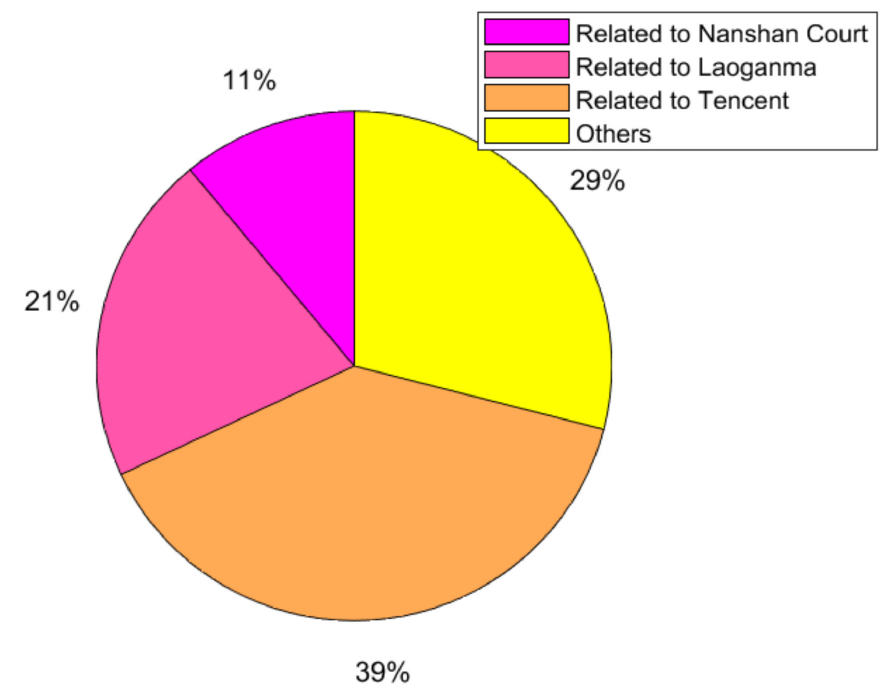
Figure 23. Classification of Weibo